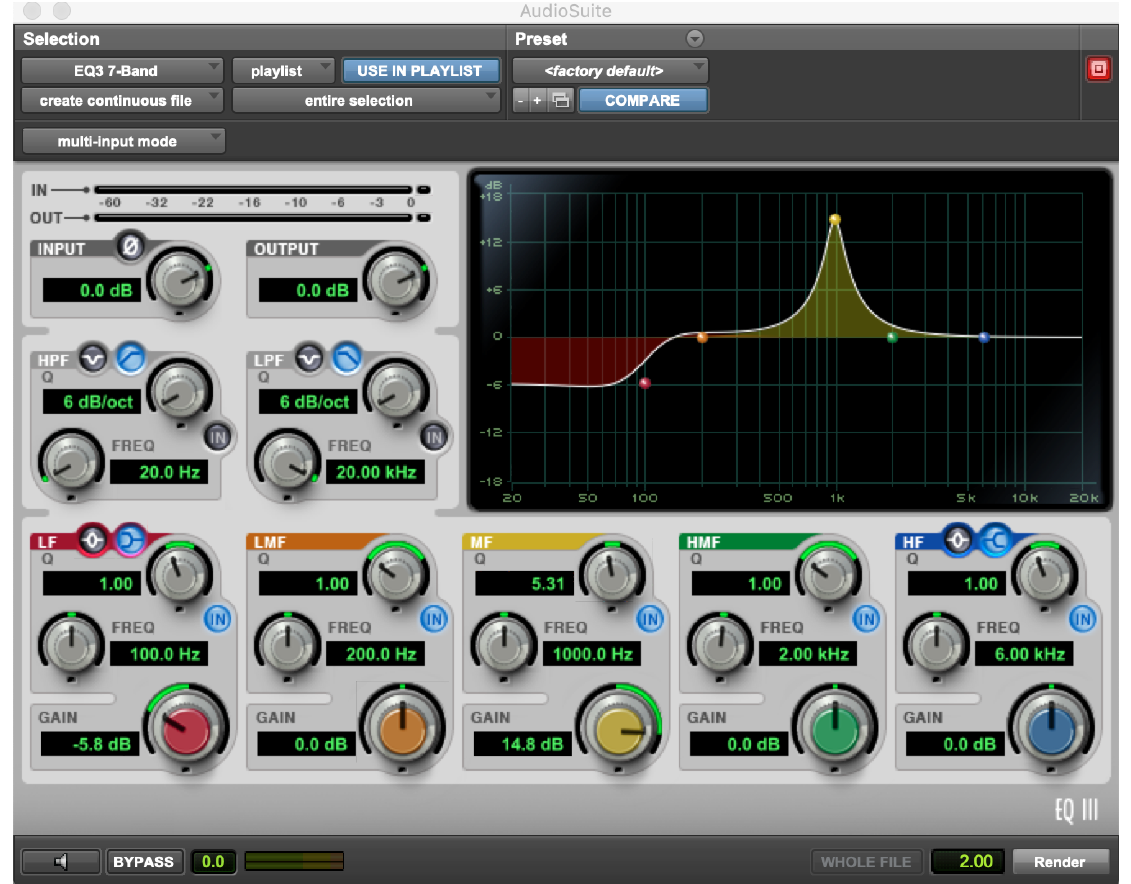
Figure 1. The parametric equalizer included with ProTools Ultimate 2019.6.0. How would you make the sound “bright” using this interface, if you did not already know the mapping between the word and how to change the frequencies? Screen capture created by the